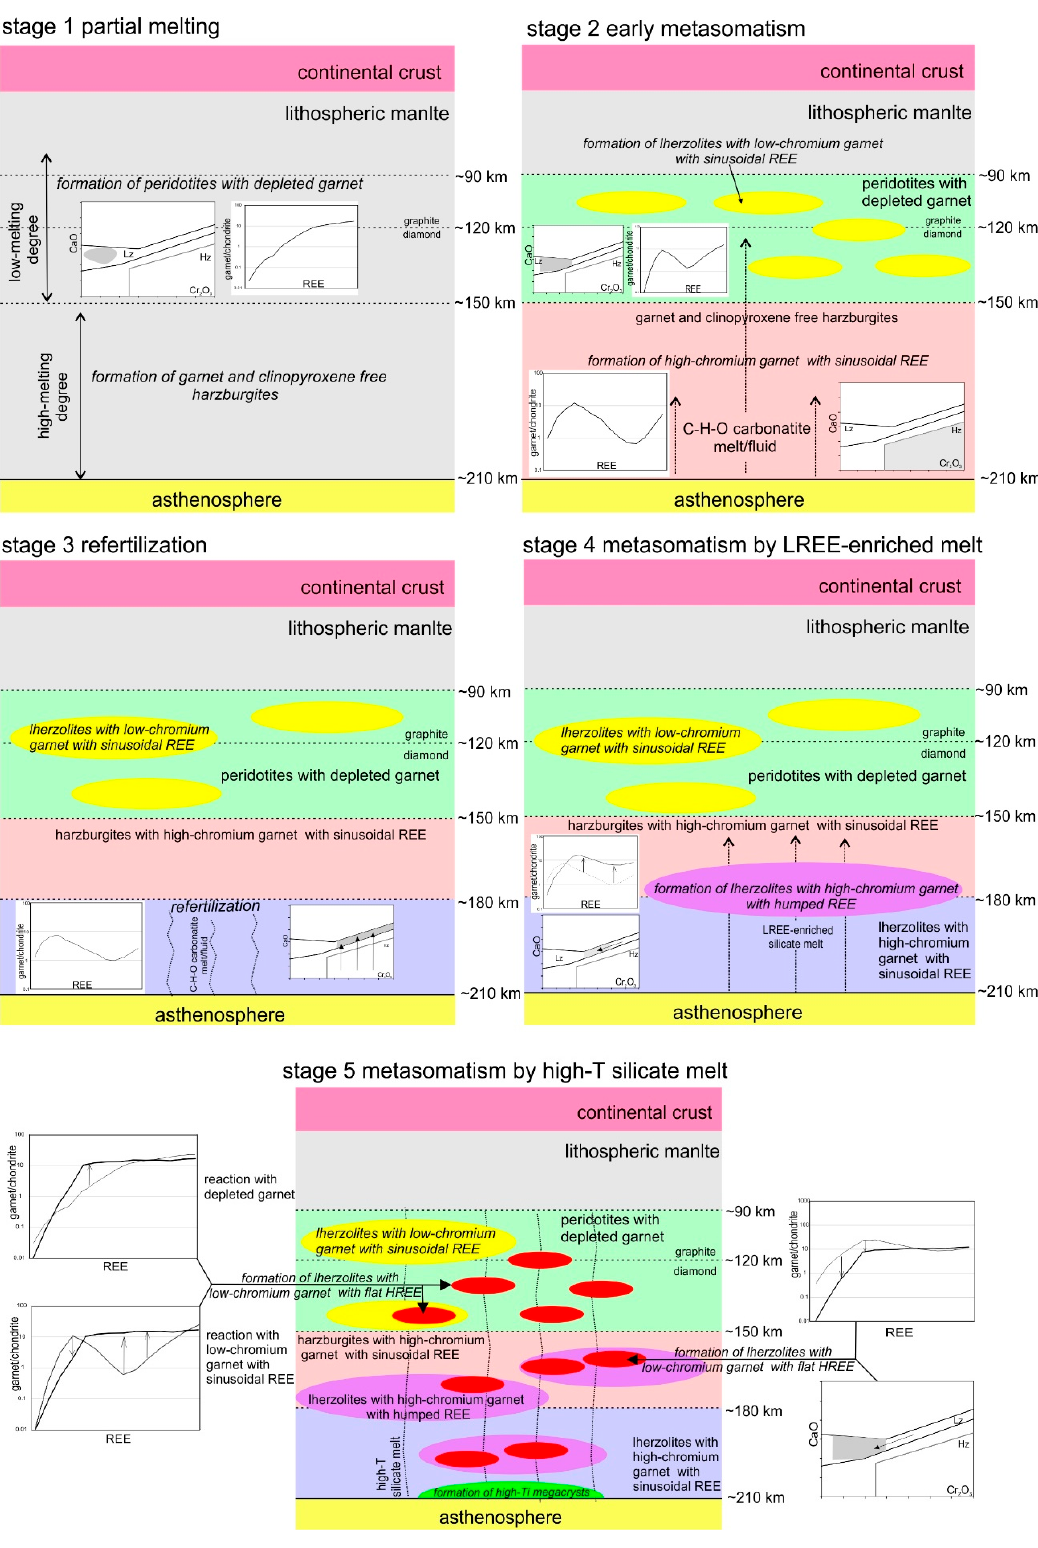
Figure 6. Schematic model of the evolution and metasomatism of lithospheric mantle beneath the southern Arkhanglesk region.